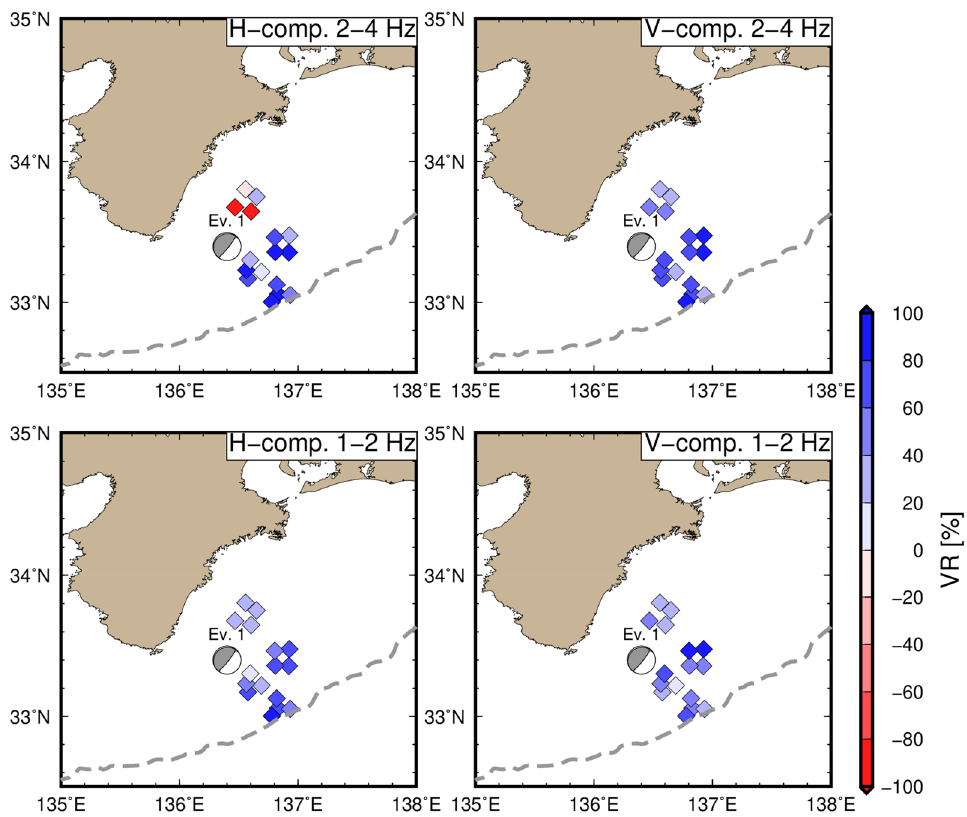
Fig. 14 Spatial variations in VRs between observed and simulated envelopes. The simulation results were normalized by the horizontal S max amplitude for each frequency band at